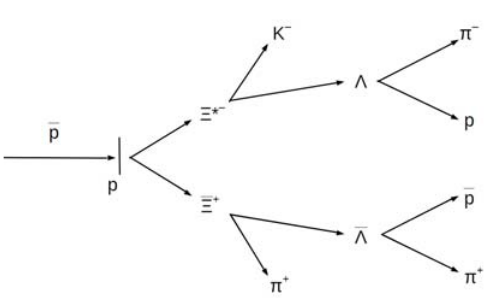
Figure 1. Illustration of the reaction including the decay chain to the detected final state.